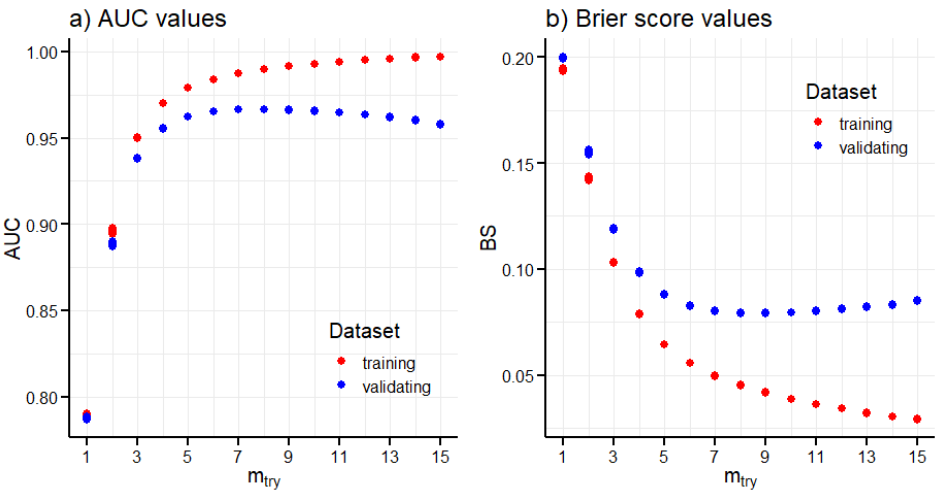
Figure 7. Values of AUC ( a ) and overall Brier score ( b ) for different values of m try . Values for each model trained during the 5-fold cross-validation were plotted